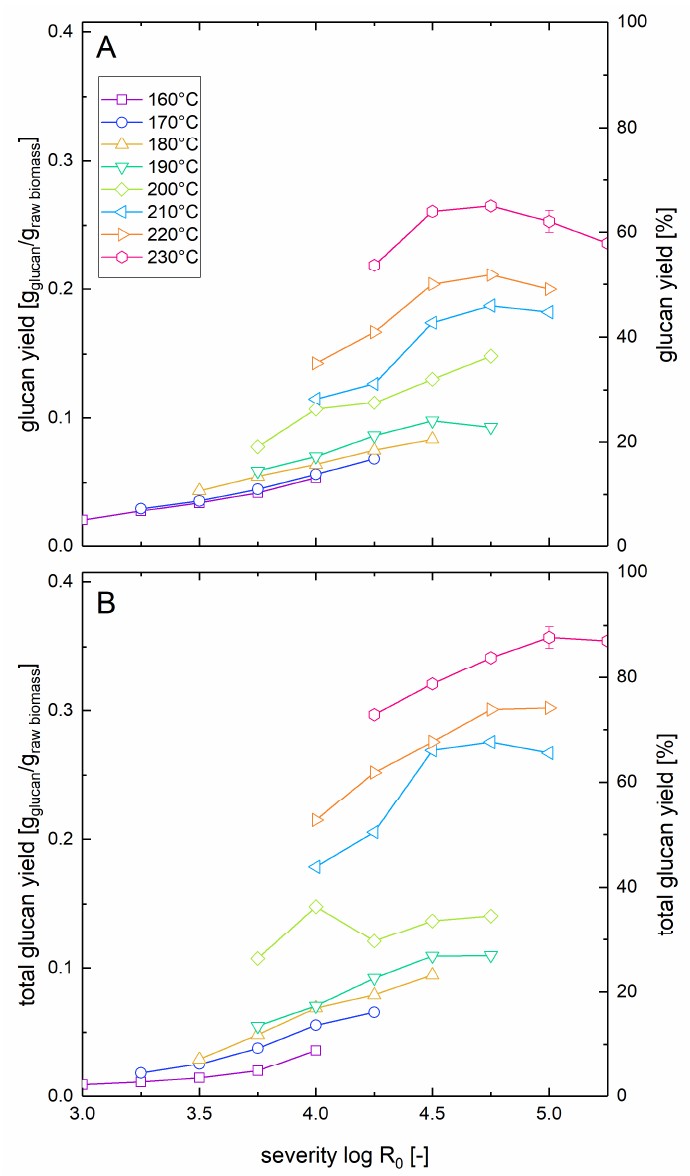
Figure 3. Solubilization and recovery of glucan after pretreatment and low solid enzymatic hydrolysis. The solubilization and recovery of glucan as glucose or soluble glucose oligomers after pretreatment and enzymatic hydrolysis was determined ( A ) after whole slurry enzymatic hydrolysis or ( B ) after combined enzymatic hydrolysis of washed solids and separate acid hydrolysis of the prehydrolyzate as a function of the pretreatment severity. A glucan loading of 1% based on the unpretreated biomass was applied in enzymatic hydrolysis